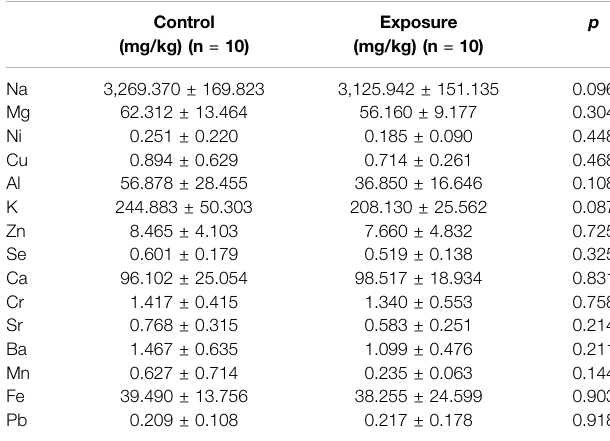
TABLE 2 | The analysis of serum metals